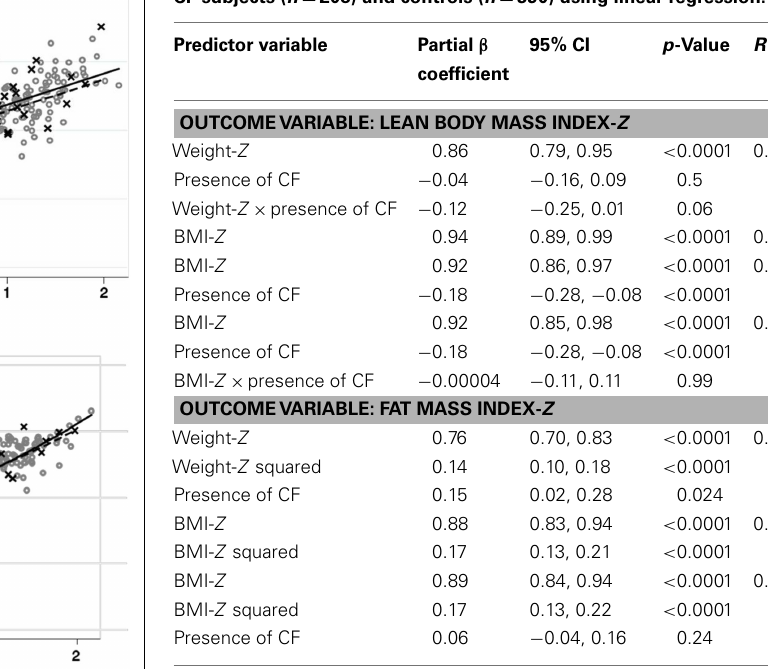
Table 2 |Association between BMI- Z and (1) LBMI- Z and (2) FMI- Z in CF subjects ( n = 208) and controls ( n = 390) using linear